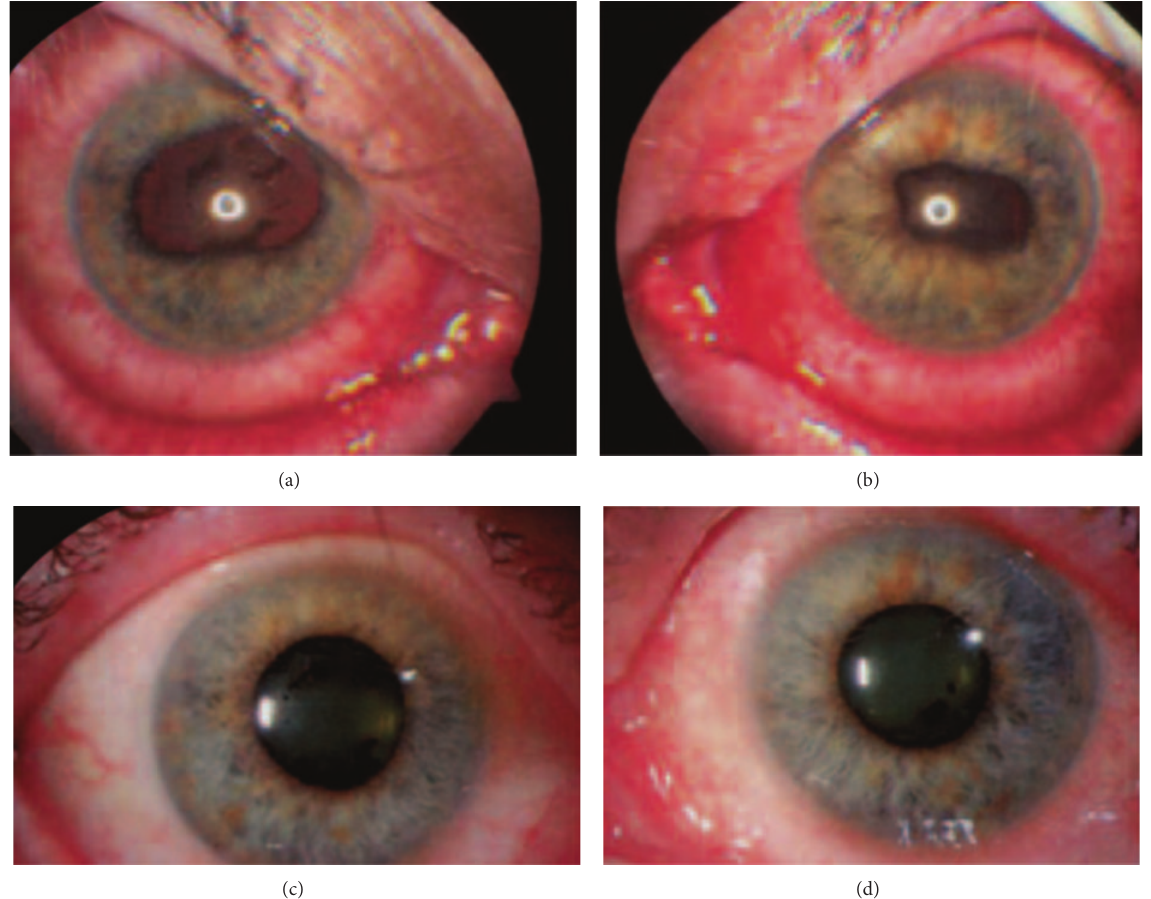
Figure 8: Ophthalmologic images of ipilimumab-associated uveitis in both eyes. (a, b) At the time of presentation, with irregular pupils caused by iris adhesions to the lens; (c, d) the same patient after 4 days of topical corticosteroid therapy [15]; reproduced with permission from Attia et al. 2005